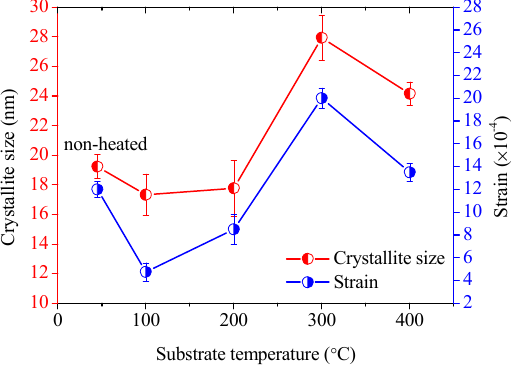
Figure 10. Dependence of average strain and crystallite size on the substrate temperature.